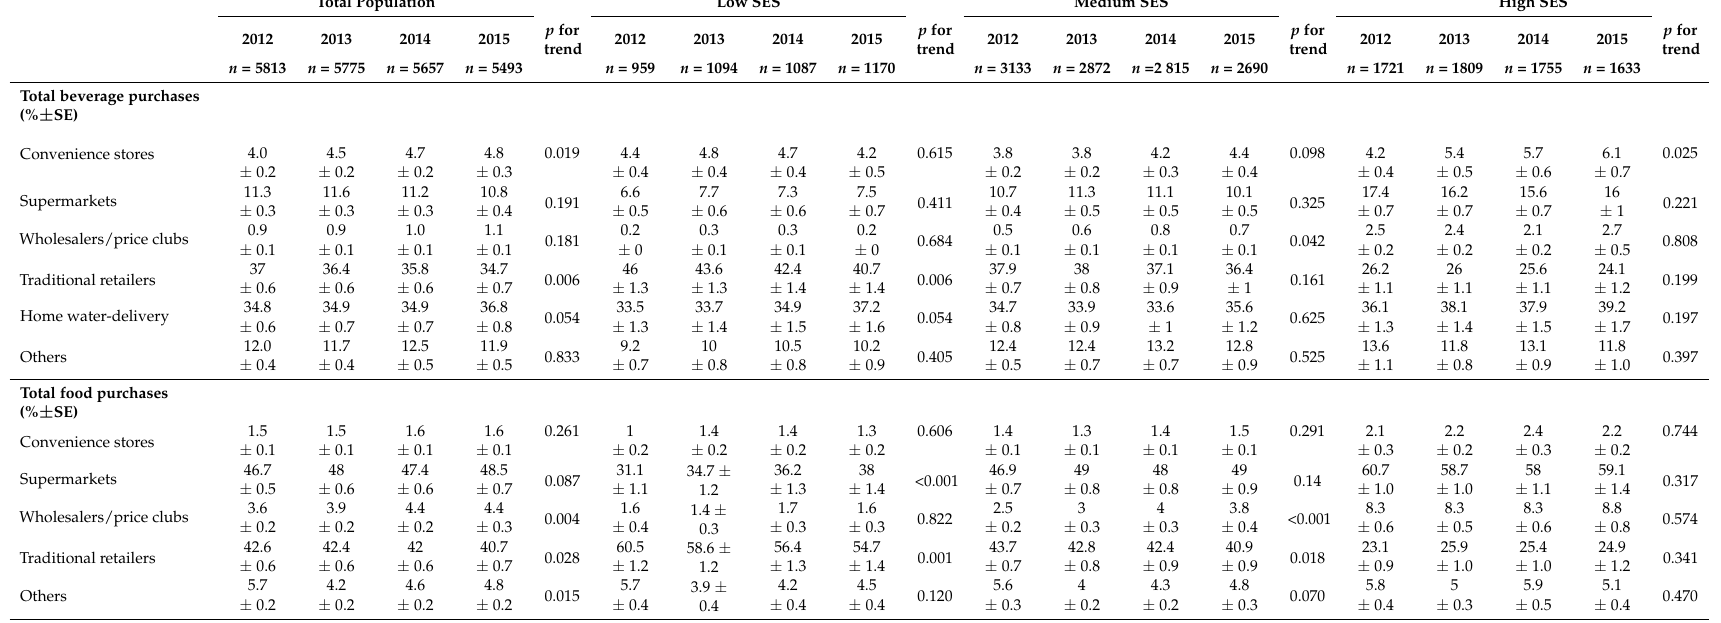
Table 1. Unadjusted percentage mean of total beverage and food purchases from 2012 to 2015 by store-type and socioeconomic